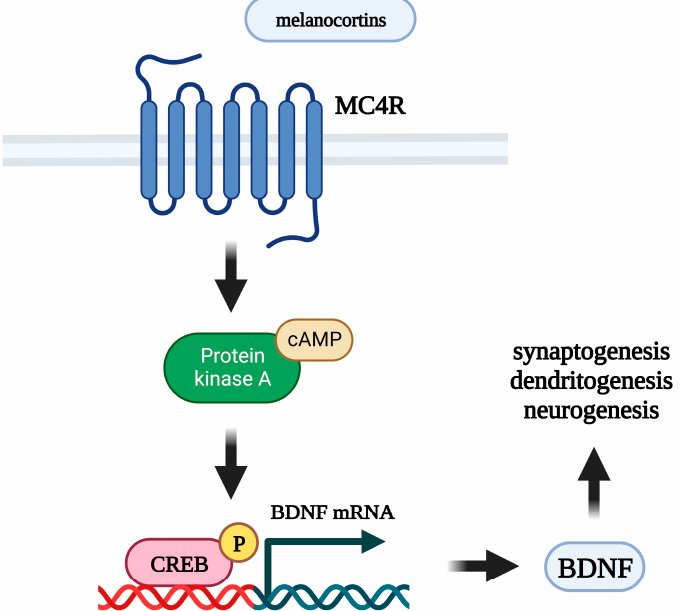
Figure 2. Mechanism of neurotrophic effects of melanocortins. MC4R: melanocortin 4 receptor; BDNF: brain-derived neurotrophic factor; cAMP: cyclic adenosine monophosphate; CREB: cAMP response element-binding protein.